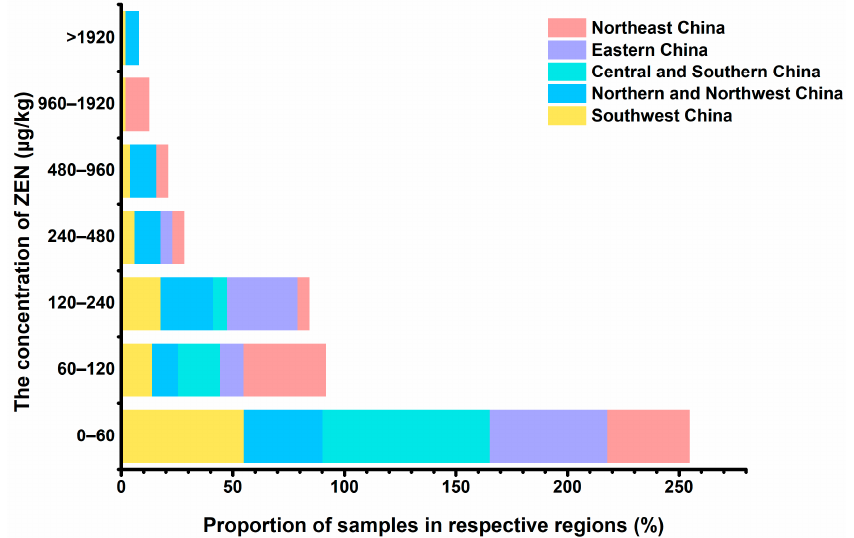
Figure 4. The concentration and distribution of ZEN in coix seeds. (Northeast China includes Liaoning and Heilongjiang Province; Eastern China includes Jiangsu, Zhejiang, Jiangxi, Shandong, Anhui, and Fujian Province; Central and Southern China include Henan, Hubei, Guangdong, and Guangxi Province, as well as Hong Kong and Taiwan; Northern and Northwest China include Beijing, Inner Mongolia, Hebei, Shanxi, and Shaanxi Province; Southwest China has Sichuan, Guizhou and Yunnan Province.). Table 3. Natural occurrence of ZEN and estimated daily exposure of adults to ZEN in common food and coix seeds samples in